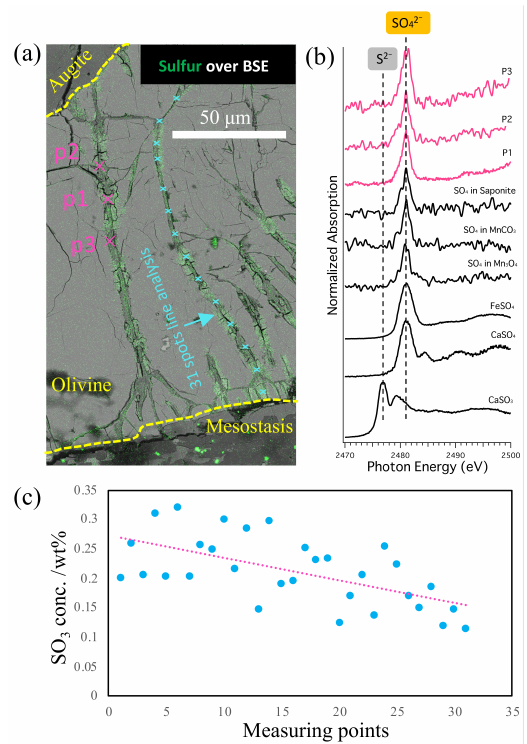
Figure 4. Analysis results of S mapping. ( a ) S elemental image obtained via EPMA (green) over the BSE image. The S is universally distributed in the carbonate iddingsite. ( b ) S K-edge XANES spectra obtained from the spots shown by pink cross marks in ( a ) p1–3. The spectra of standard materials are also shown. ( c ) SO 3 concentration by EPMA obtained from the light blue cross-marked region in ( a